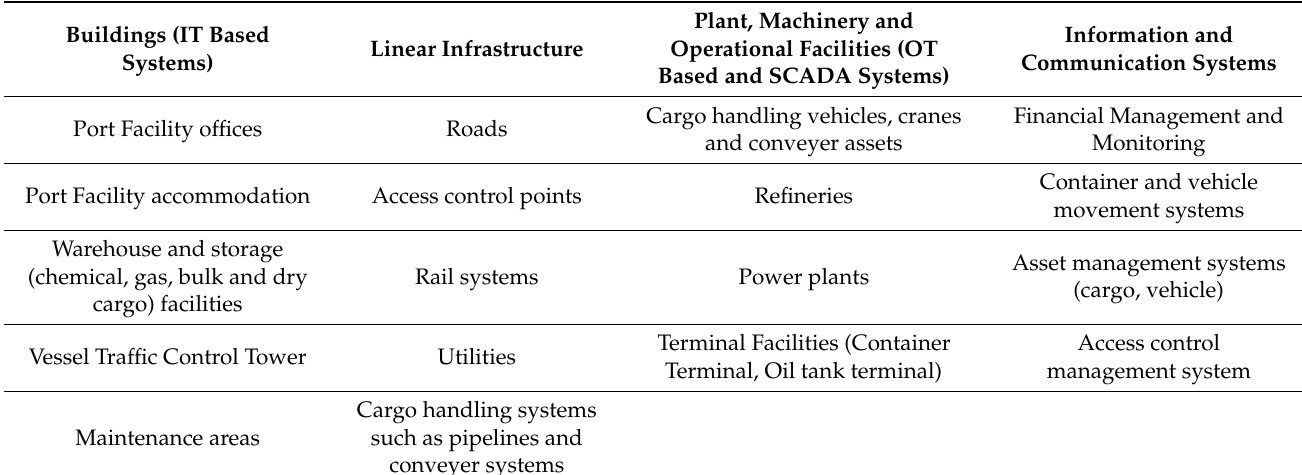
Table 1. Port ecosystem